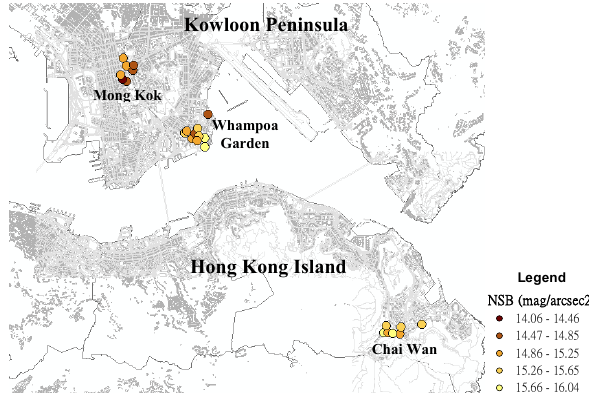
Figure 4. Locations of study areas and NSB measurements for regional scale